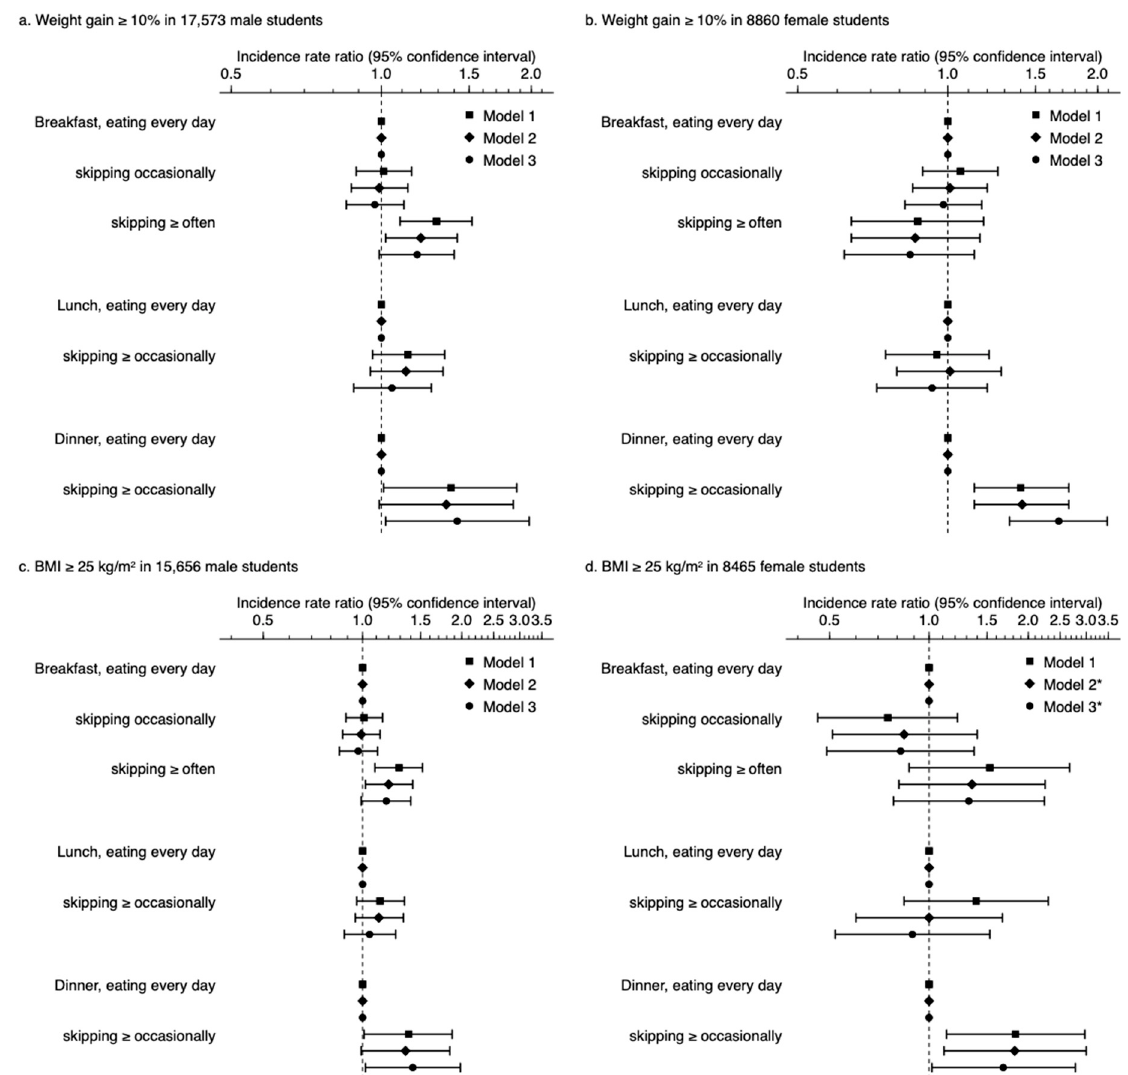
Figure 3. Meal frequency and incidence of ≥ 10%weight gain ( a , b ) and body mass index (BMI) ≥ 25 kg/m 2 ( c , d ). BMI, body mass index. Model 1, unadjusted. Model 2, adjusted for admission year (2007, 2008, 2009, 2010, 2011, 2012, 2013, 2014, and 2015), age (18, 19, 20, and ≥ 21 years), BMI (kg/m 2 ), smoking status (non-smokers and smokers), drinking status (non-drinkers and drinkers), dinner time (before 7 PM, 7–9 PM, 9–11 PM, and after 11 PM), and sleep duration on weekdays (<5, 5–6, 6–7, 7–8, and ≥ 8 h). Model 3, adjusted for covariates in model 2 and frequencies of breakfast, lunch, and dinner (e.g., breakfast frequency was adjusted for lunch and dinner frequencies). * Not adjusted for smokers because of no incidence of the outcome in smokers (n = 13).